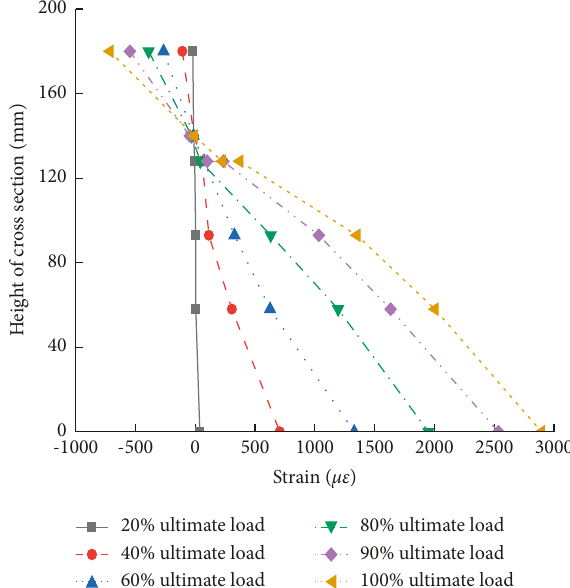
Figure 14: Strain in the cross section of the middle span.